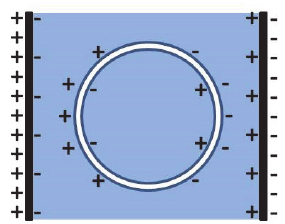
Fig. 3: Single-shell cell model obtained by introducing the water droplet (Figure 2b) into a slightly larger air bubble (Figure 2a), leaving an air film (i.e. a "biological membrane") around the droplet’s surface. It was assumed that the external bulk medium has a lower conductivity than the internal bulk while both bulk media are isotonic.